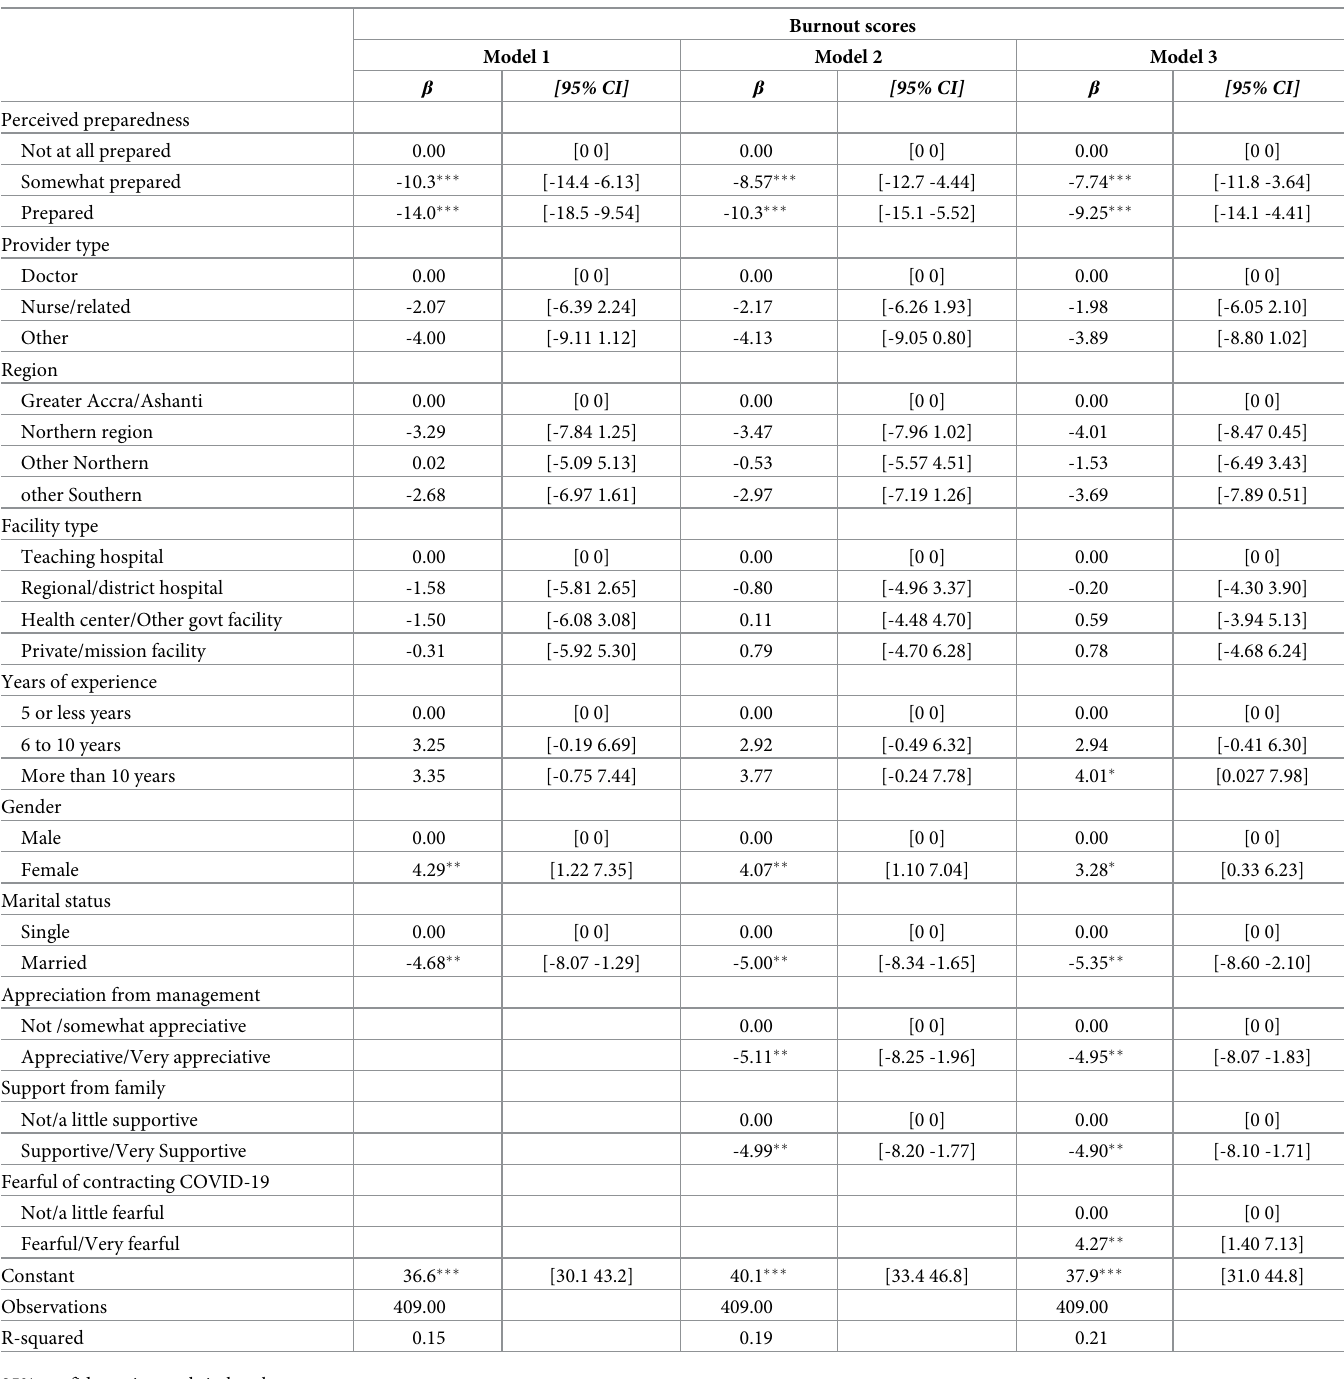
Table 4. Multivariable linear regression of potential predictors on burnout of healthcare workers in Ghana (N =